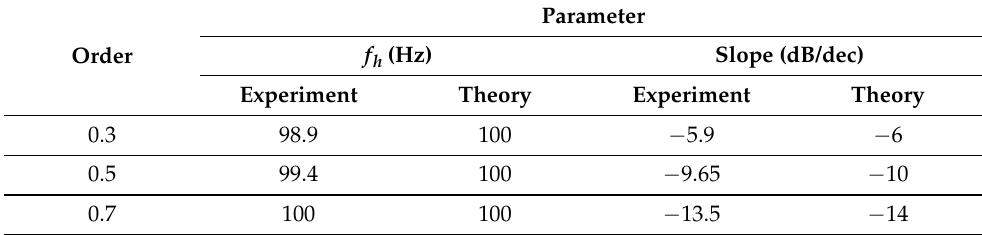
Table 4. Frequency characteristics of LP filter responses in Figure 5.